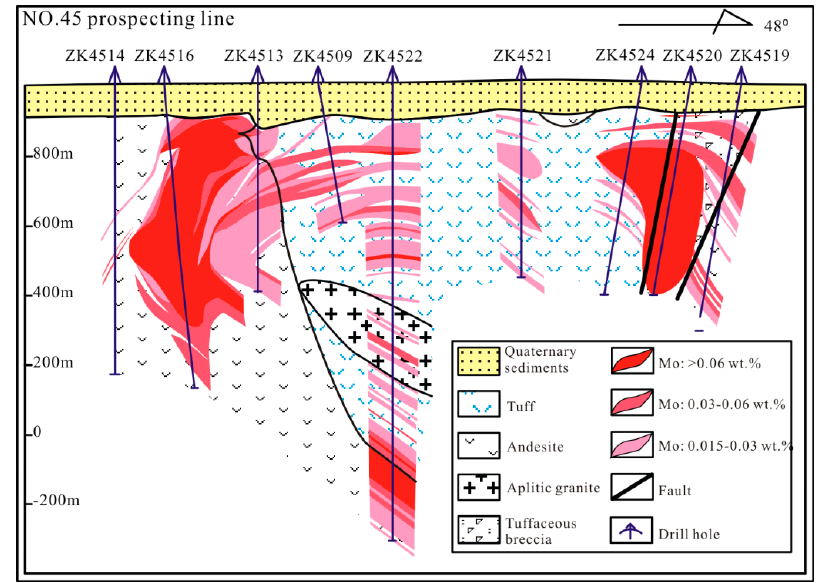
Figure 3. Geological profile of exploration line 45 in the Diyanqinamu mine.